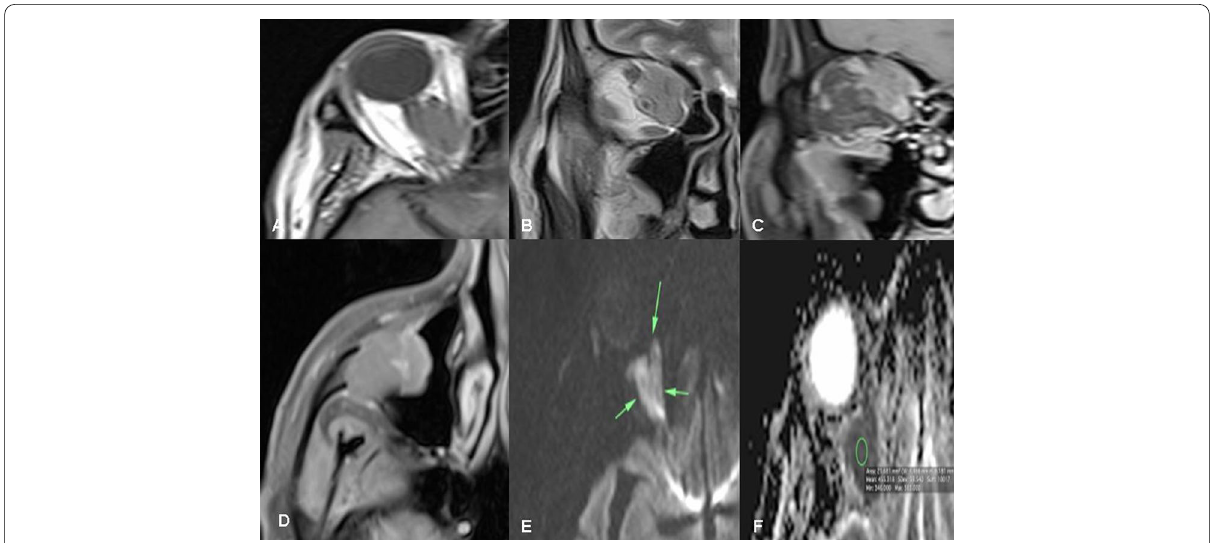
Fig. 8 A 59-year-old female with right-sided dull aching orbital pain and limited right orbital movement. Axial T1 image A shows T1 hypointense infiltrative right retrobulbar intraconal mass involving the right medial rectus muscle, the related intraconal fat planes and inseparable from the optic nerve. Coronal T2 image B shows isointense signal of the lesion. Coronal T1 post-contrast image C reveals homogeneous enhancement of the retrobulbar lesion with possible invasion of the orbital roof. Axial T1 post-contrast image D shows similar infiltrative submucosal mass seen in the left maxillary sinus. Evident diffusion restriction on DWI (b 1000 )/ADC ( E , F ). The ADC value of 0.46 right-sided retrobulbar lymphoma (NHL) partially encasing the left optic nerve